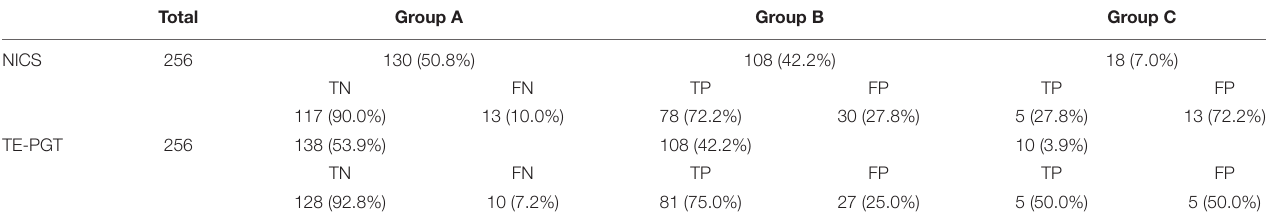
TABLE 4 | Categorizing embryos according to NICS and TE-PGT